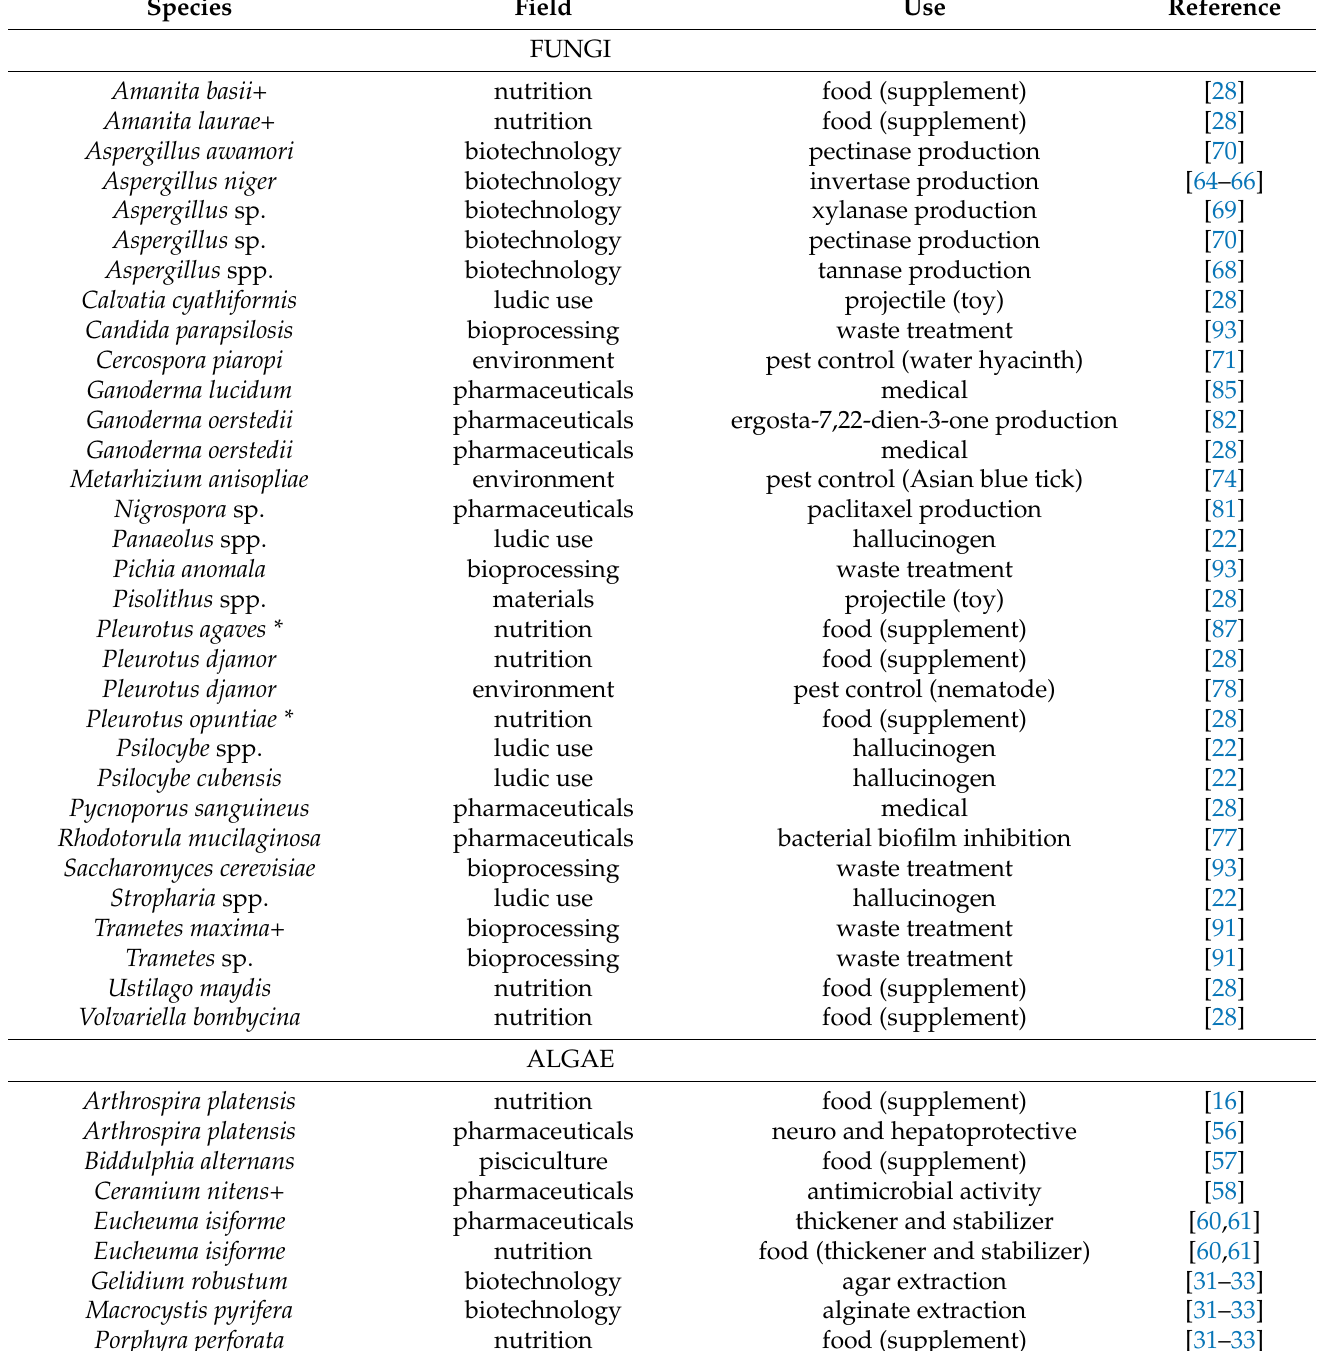
Table 1. Examples of fungi and algae, and their applications in